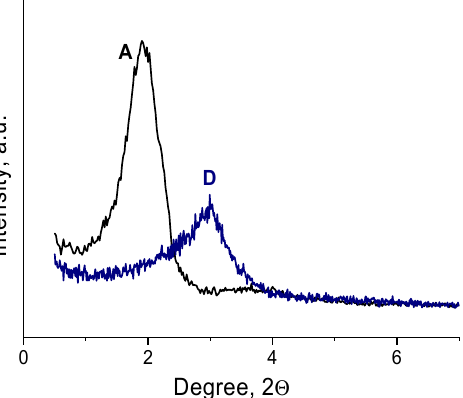
Figure 2. Representative XRD patterns of calcined Zr-MMM-E (samples A and D ). DR UV–vis spectra of the Zr-MMM-E and Zr/SiO 2 catalysts are shown in Figure 3. Sample A synthesized without additional HCl revealed a sharp band with a maximum at 205–210 nm, that is usually attributed in the literature to the ligand-to-metal charge transfer from O 2 − to Zr 4+ ion isolated in a silica matrix [44,60–64]. On the contrary, the spectrum of sample D prepared with additional 7 equiv of HCl displays a broad absorption in the range of 240–280 nm with a maximum centered at 250–270 nm, which can be assigned to nanoscopic regions of Zr-O-Zr linkages (ZrO 2 -like domains) [44,61,64]. The other two materials obtained with 1 and 2 equiv of HCl exhibit both adsorptions, although at a different ratio. It is also worth noting a small shoulder at 220 nm in the spectra of samples B and C , which can be attributed to small Zr-O-Zr clusters (oligomers) [44,62]. In general, the more amount of HCl added during the synthesis, the higher contribution of oligo(poly)meric ZrO 2 species and their size. The Zr/SiO 2 sample prepared by dry impregnation of silica exhibited a DRS-UV band with a maximum at ca. 210 nm and a shoulder around 240–270 nm (Figure 3), indicating the large occurrence of quasi isolated Zr(IV) species on the silica surface.